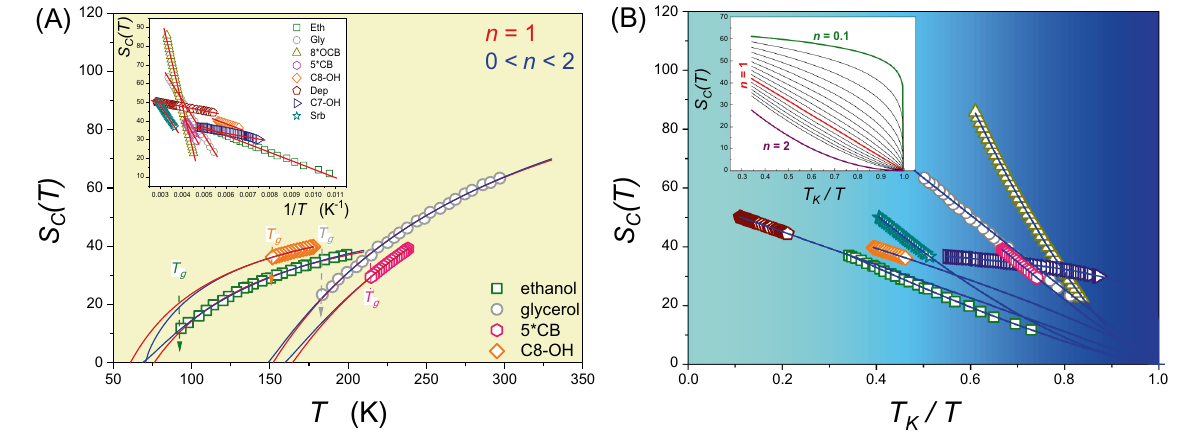
Figure 1. Configurational entropy for supercooled liquids. ( A ) Data portraying entropy behaviour for glycerol 57 , ethanol 58 , cyclooctanol 61 and 5 * CB liquid crystal 62 . Red and blue straight lines denote Eq. (5) and Eq. (10) respectively. Dashed arrows present glass transition temperatures T g . The insert shows configurational entropy as a function of reciprocal temperature S c ( 1 / T ) for all studied systems. ( B ) Configurational entropy normalised to the Kauzman temperature T K for all samples basing on generalised Eq. (10). Impact of different n parameter on Eq. (10) is shown as an insert. Limit values n = 0.1 and n = 2 as well as classical case for n = 1 are marked by bold lines. Fitting parameters may be found in Table